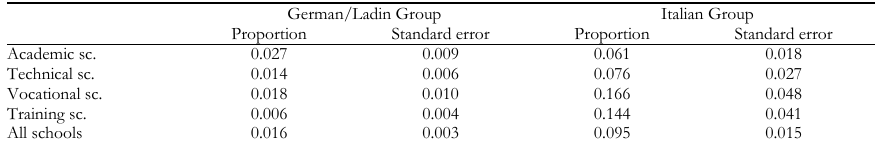
Proportion of immigrant students in Bolzano by school type and language